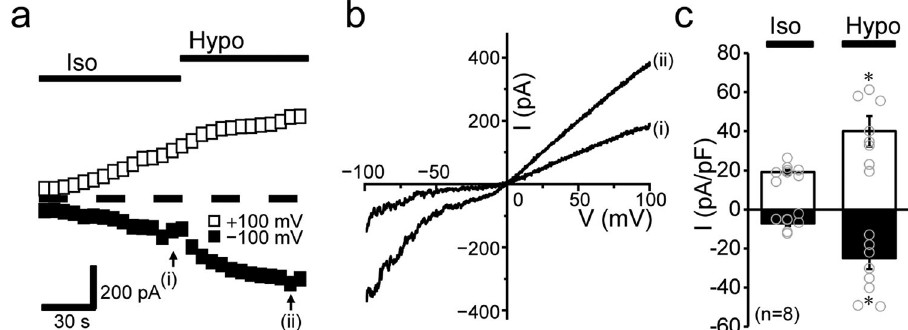
Fig. 4 Augmentation of whole-cell TRPM7 currents by hypotonic stimulation in DT40 cells. a Effects of hypotonic stimulation on whole-cell TRPM7 currents under ramp-clamp (every 5 s at 4 mV/ms) in the cells equilibrated with the ATP-free and low-Cl − intracellular (pipette) solution. Representative peak outward and inward currents recorded at + 100 and − 100 mV, respectively, before ( Iso ) and after ( Hypo ) application of hypotonic (86% osmolarity) solution. b Representative I – V relationships of currents in response to ramp pulses (50-ms duration) from − 100 to + 100 mV before (at i in a ) and during (at ii in a ) hypotonic stimulation. c Peak current densities at + 100 (blank columns) and − 100 mV ( fi lled columns) in isotonic ( Iso ) and hypotonic ( Hypo ) conditions ( n = 8). Each data point represents the mean ± SEM (vertical bar) of n samples. * P ( = 0.0029 and 0.00017 at + 100 and − 100 mV, respectively) <0.005 compared to corresponding data in Iso group by t